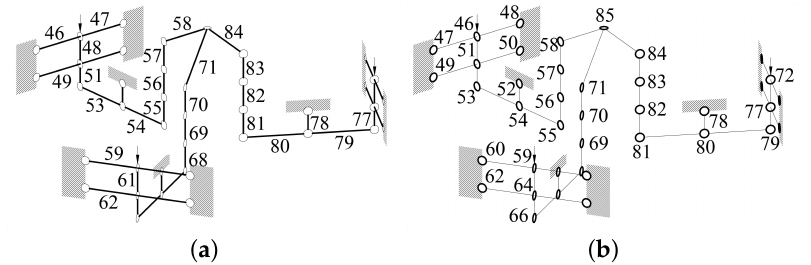
Figure 9. Simplified equivalent statics model of the three out-of-plane chains. ( a ) Frames; ( b ) nodes.